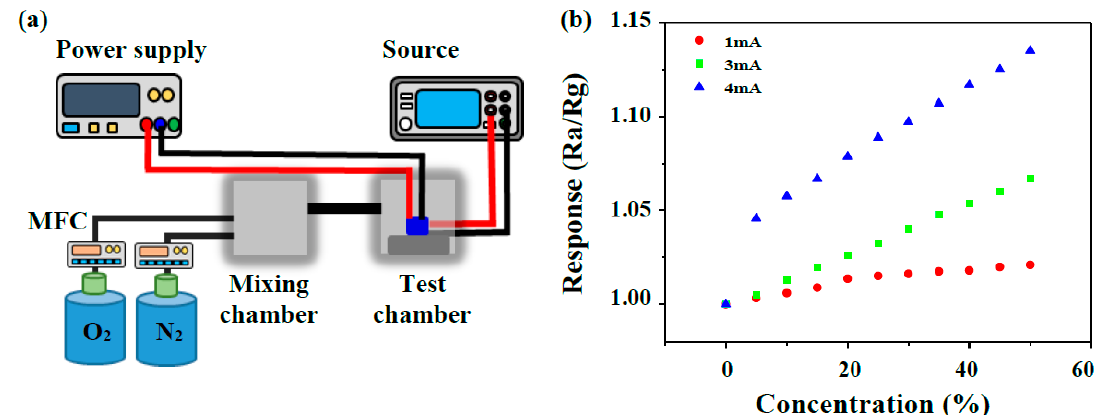
Figure 7. ( a ) Experimental setup for gas sensing tests, and ( b ) responses of the ZnO-SnO 2 sensors based on different operation current and oxygen